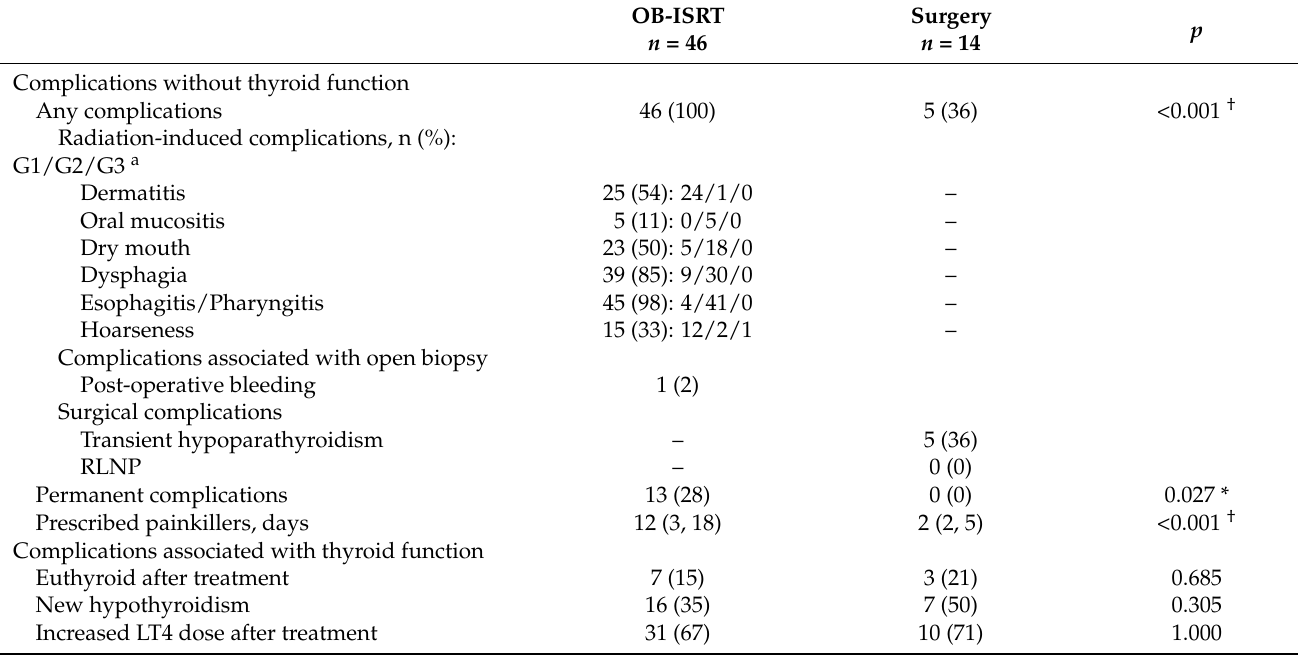
Table 2. Comparison of treatment-related complications between the OB-ISRT and Surgery groups.